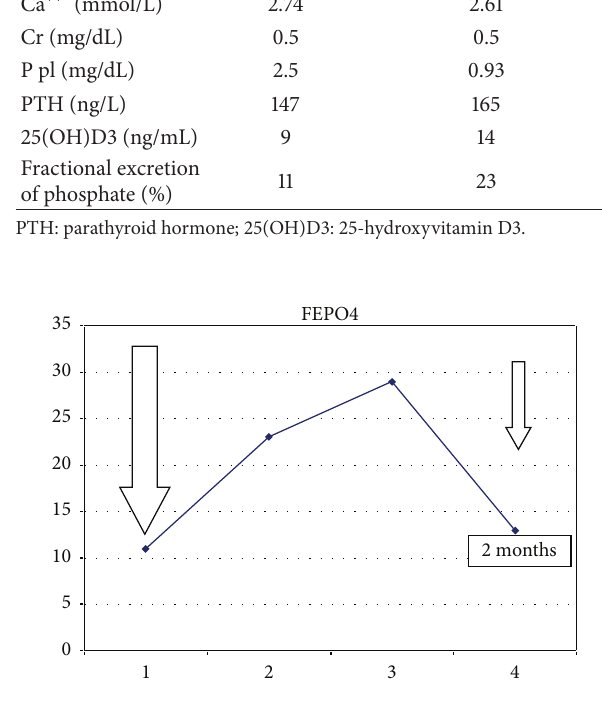
Figure 1: Evolution of FEPO 4 (%) after administrations of ferric